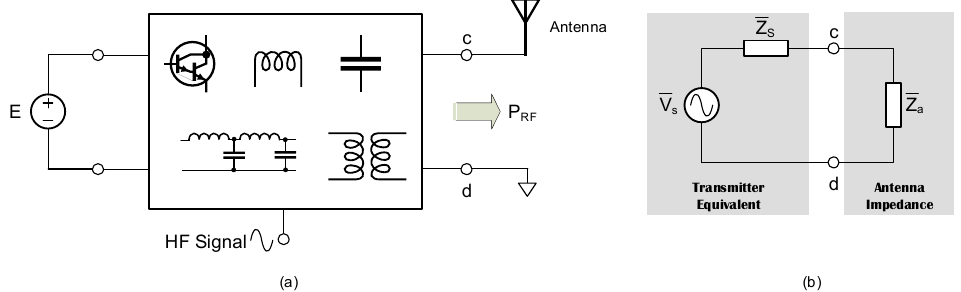
Figure 17. ( a ) The “black box”-based model of transmission system. ( b ) Equivalent circuit as viewed from the load (antenna).